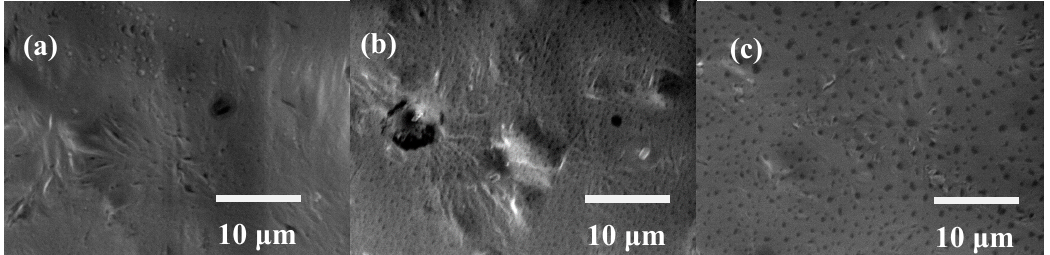
Figure 4. SEM images of the 316L SS coated with ( a ) 2%; ( b ) 3%; and ( c ) 4% PCL films.